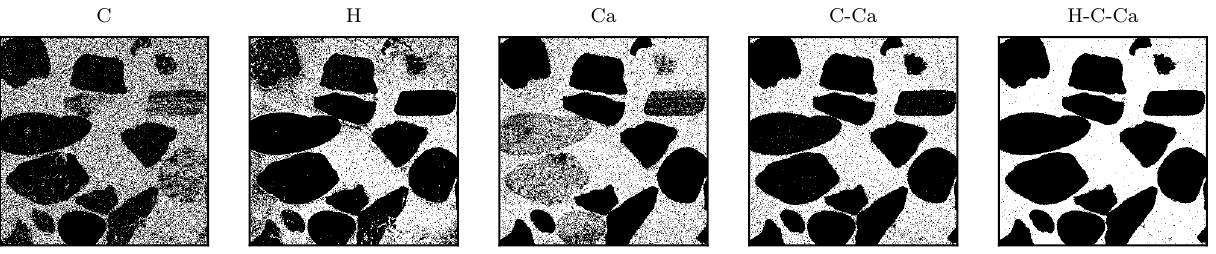
Figure 9. Training iterations to find the optimized setting for training the model and the quality of segregation in